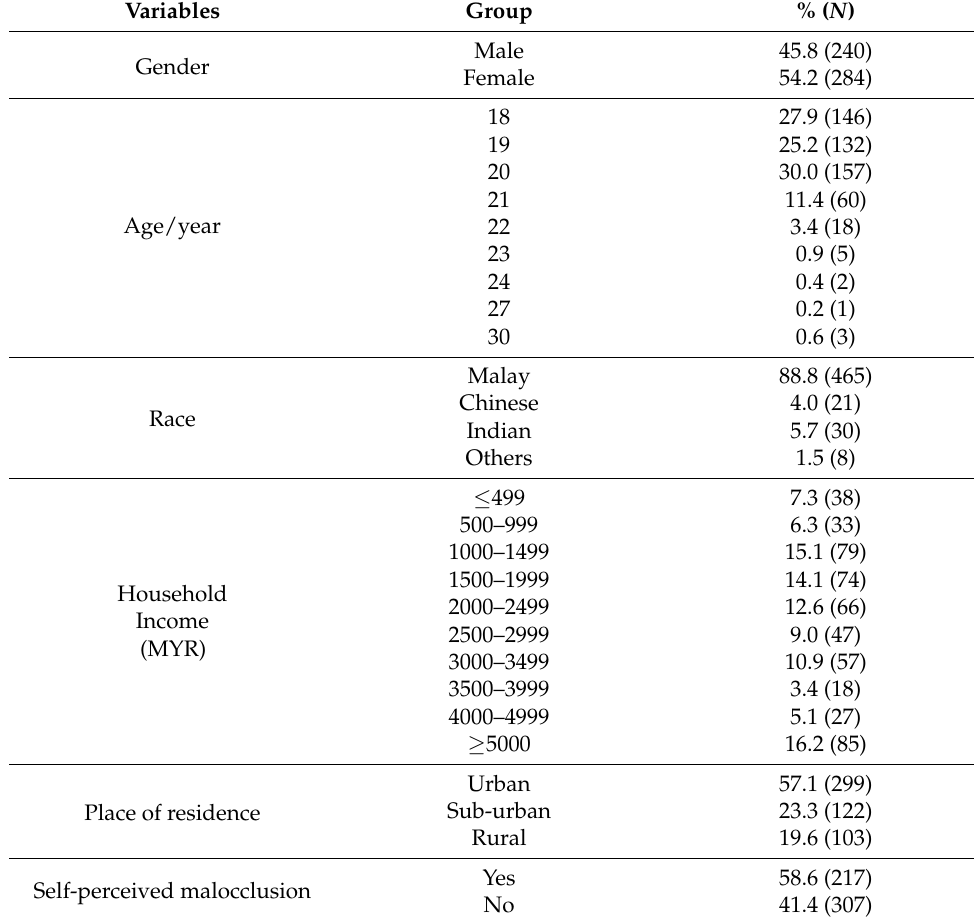
Table 1. Socio-demographic characteristics of the subjects including presence of self-perceived malocclusion ( N =